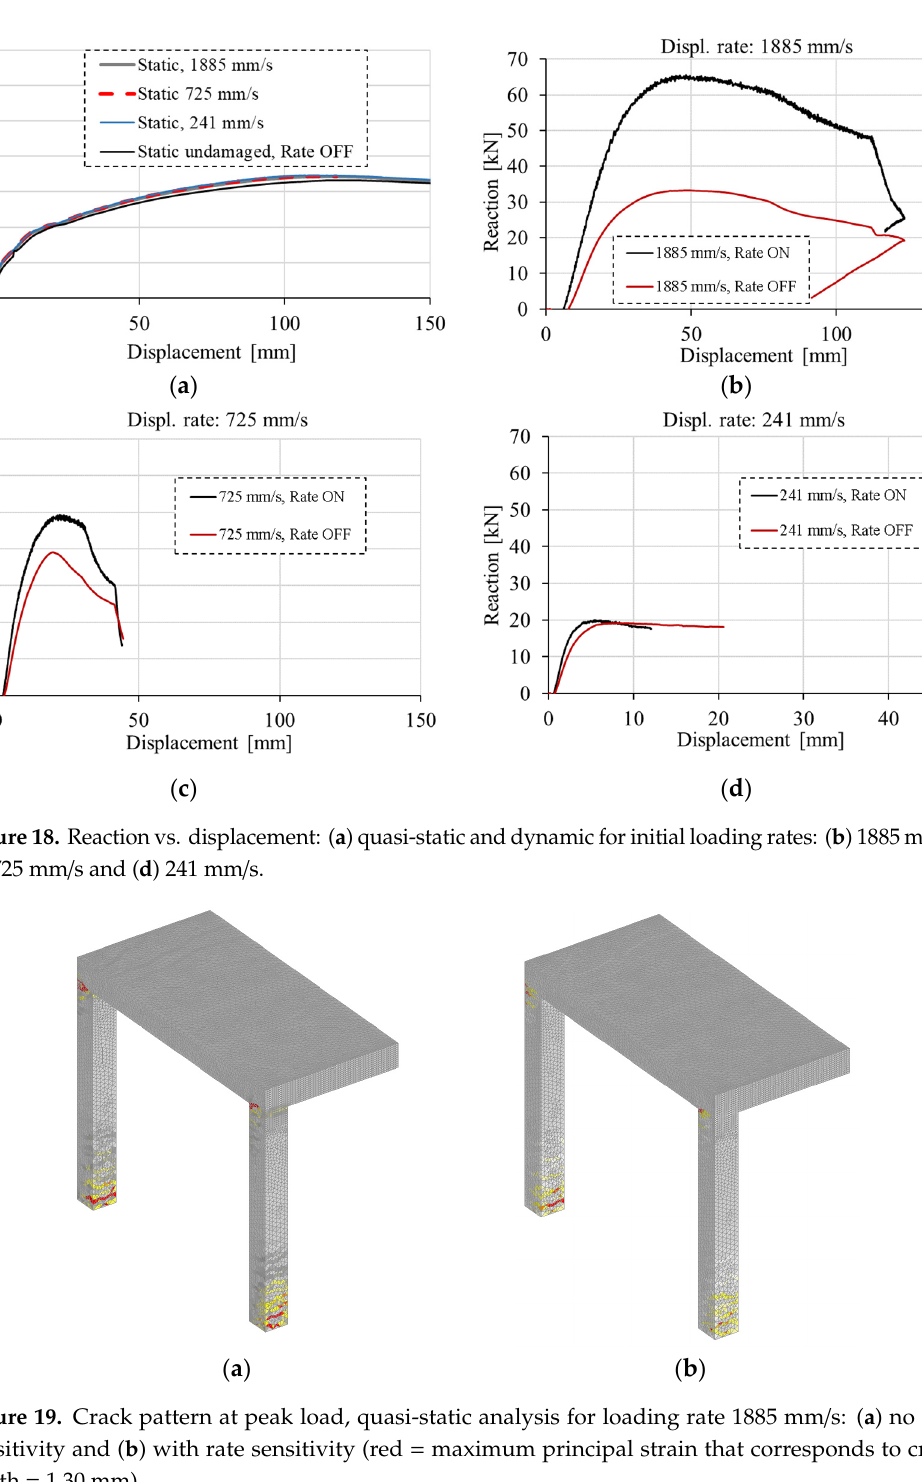
R a t e O FF Figure 20. Dynamic analysis, failure modes for different loading rates with and without rate sensitivity (red = maximum principal strain that corresponds to crack width = 3 mm). 5. Summary and Conclusions In the present study, static and dynamic 3D FE simulations of initially undamaged and damaged RC frames are carried out. Based on the results the following can be concluded: (i) The comparison between experimental test and numerical simulation shows that the thermo-mechanical transient analysis based on the temperature dependent microplane model is able to realistically replicate the experimental dynamic test of thermally pre-damaged RC frame; (ii) It is shown that instead of local